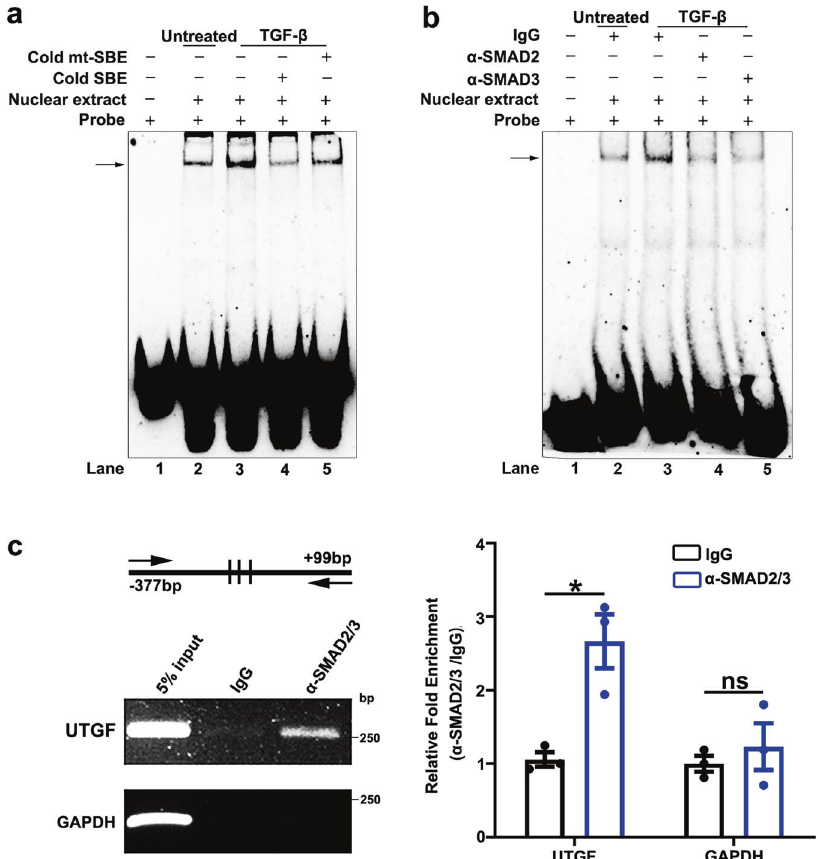
Fig. 3 SMAD2 and SMAD3 directly bind to the lnc-UTGF promoter in vitro and in vivo. a , b EMSA and antibody-supershift assays veri fi ed the in vitro interaction of SMAD2/3 with SBEs in the lnc-UTGF promoter. DNA – protein complexes are indicated by the arrows. Nuclear extracts were isolated from SK-HEP-1 cells untreated or treated with TGF- β for 2 h. Probe: biotin-labeled oligonucleotides that comprise SBE sequence in the lnc-UTGF promoter. Cold SBE: unlabeled oligonucleotides that contain consensus SMAD-binding element (SBE). Cold mt-SBE: unlabeled oligonucleotides that contain mutant SBE. c SMAD2/3 interacted with the lnc-UTGF promoter in vivo. SK-HEP-1 cells were incubated with TGF- β for 1 h before ChIP assay. The antibody-precipitated DNAs were ampli fi ed by semi-quantitative PCR for 35 cycles ( left panel ) or by qPCR ( right panel ). Arrows: the PCR primers. 5% input: 5% of the total DNAs were ampli fi ed to serve as the control for DNA content. Values shown are fold enrichment of α -SMAD2/3-precipitated DNA relative to the isotype-matched IgG control. The promoter region of GAPDH was used as a negative control. + or − , cells with ( + ) or without ( − ) the indicated treatment. Error bars: SEM from three independent experiments. *, P < 0.05, ns, not signi fi